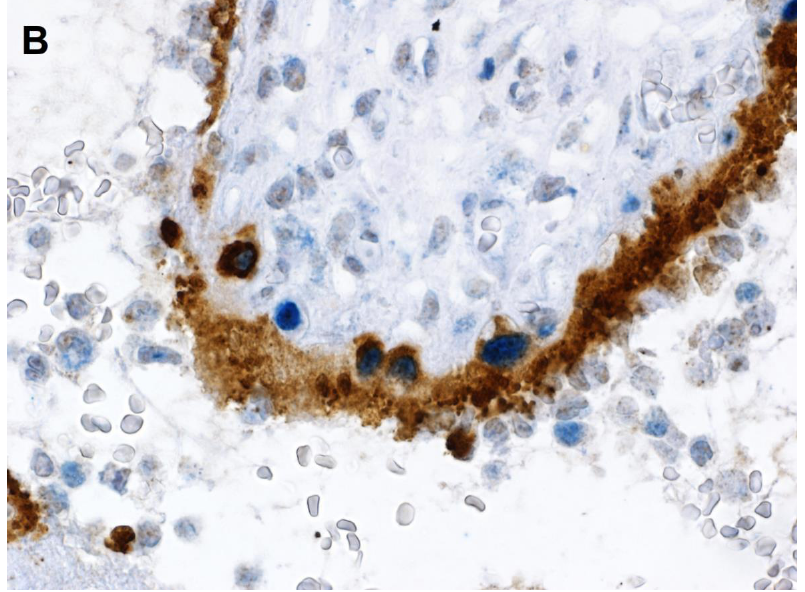
Figure 5. ( A , B ). Double-staining immunohistochemistry using GATA3 (blue) and antibody to SARS-CoV-2 nucleocapsid protein (brown). The overlying syncytiotrophoblast are diffusely positive (brown intracytoplasmic staining) for SARS-CoV-2 antigen. In addition, there are cytotrophoblast cells located beneath the syncytiotrophoblast layer that have positive (blue) intranuclear staining for GATA3, and also have intracytoplasmic positivity (brown) for coronavirus. In both images there are cytotrophoblast (blue nuclei) that do not demonstrate intracytoplasmic staining for SARS-CoV-2 antigen. Double staining with antibodies to GATA3 and SARS-CoV-2 nucleocapsid protein, ×40.